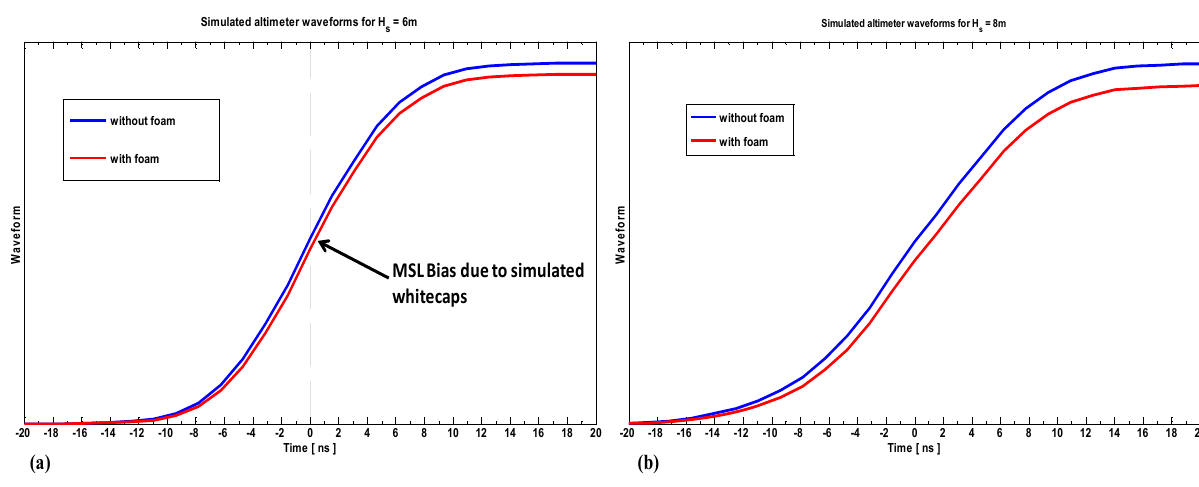
= 6 m; ( b ) H = 8 m. s s